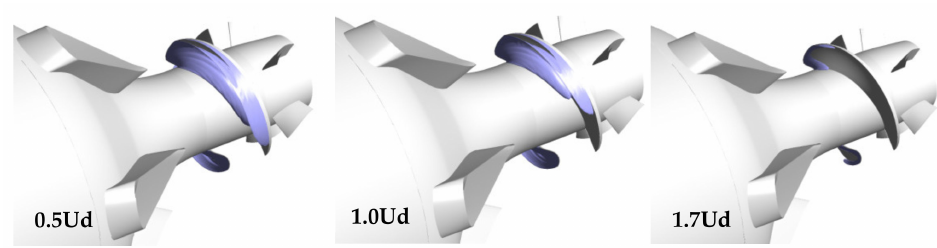
Figure 23. Distribution of the cavity cloudy in the water jet pump